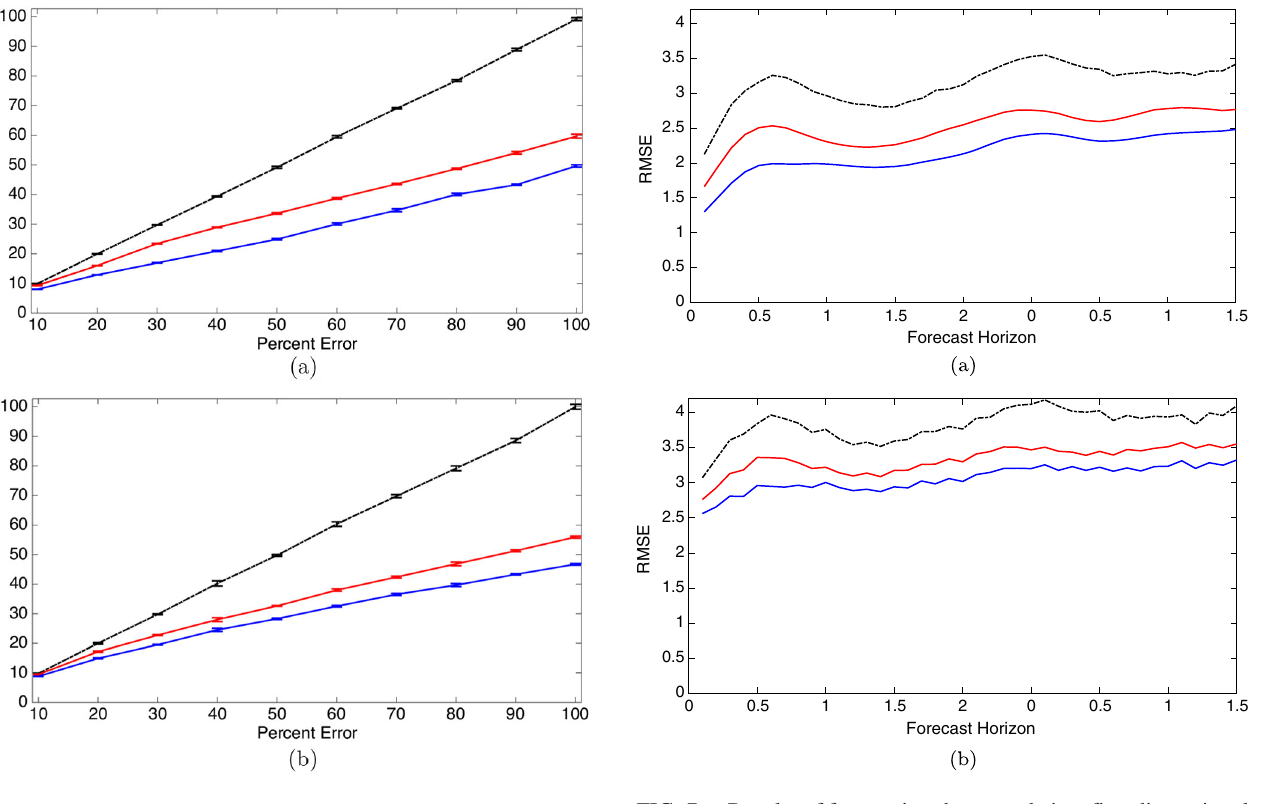
FIG. 6. Filter performance of the parametric (solid blue curve) and Kalman-Takens filter (solid red curve) when denoising the observed Lorenz-96 x 1 variable at increasing levels of observa- tion noise (signal error, dotted black curve). The variable is sampled at rate h ¼ 0 . 05 and the error bars denote standard error over 10 realizations. Q and R noise covariances are tuned off-line for optimal performance of the filters. Results presented for both a (a) five-dimensional Lorenz-96 system with only x 1 observable and a (b) 40-dimensional Lorenz-96 system where x 1 , x 2 , and x 40 are observable. We assume additional nodes are observable in the 40-dimensional case due to the high dimensionality of the system, which inhibits both the parametric and Kalman-Takens filter. In both systems, the Kalman- Takens filter is able to significantly reduce the signal error to a level comparable to the parametric filter that has full knowledge of the system.